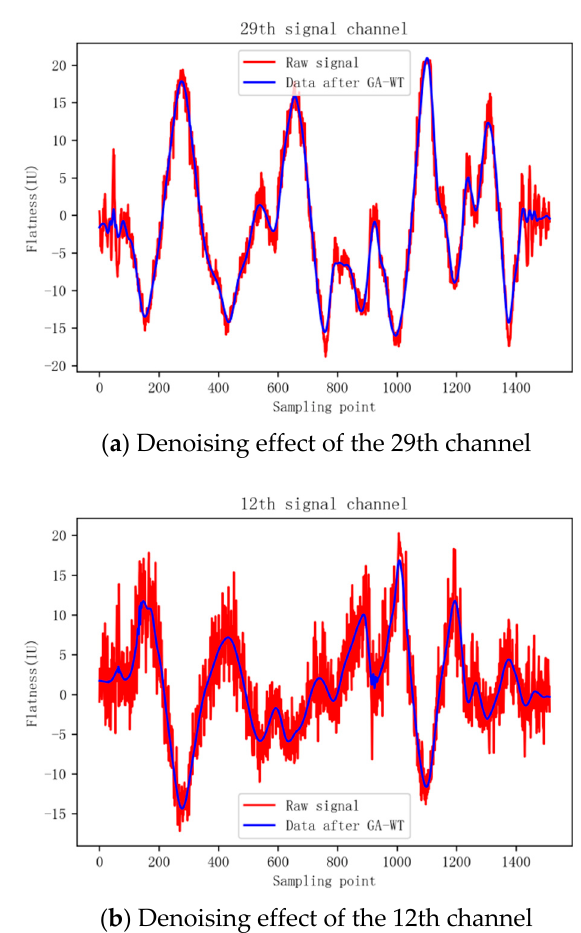
Figure 5. Denoising effect of certain signal channels.